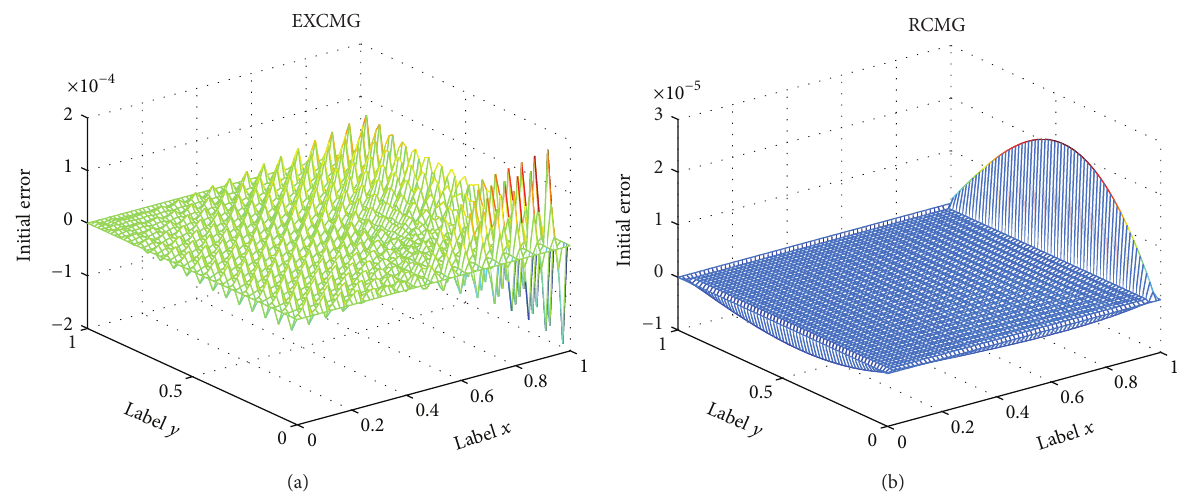
Figure 2: Example 4, grid 64 × 64 , initial error of EXCMG ((a) scale 10 −4 ) and RCMG ((b) scale 10 −5 ).